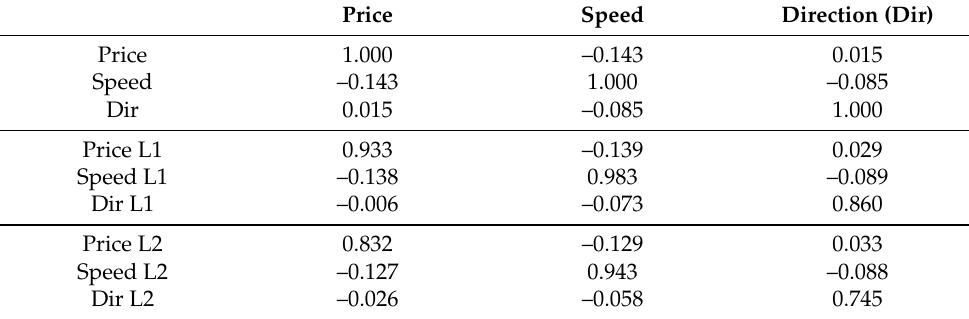
Table 3. Cross-correlations between series and time